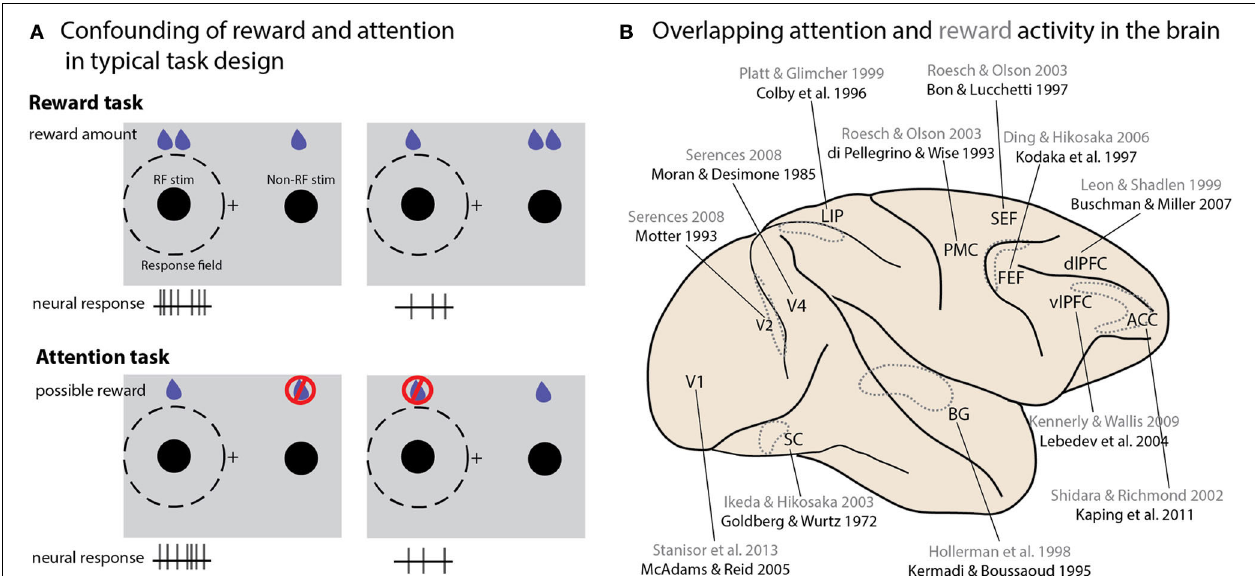
FIGURE 2 | Interactions between attention and reward. (A) A schematic illustration of typical tasks used to study reward and attention, and how the differences in potential reward and neural activity are similar between the two paradigms. Consider two studies conducted in V1 (Stˇani¸sor et al., 2013 and McAdams and Reid, 2005). To study the effect of reward size in the Stˇani¸sor task (schematically illustrated in the top panel), two potential targets appear, with colors indicating different reward values. Neural activity recorded at this point in the task reflects the relative value of the target in the RF (higher activity when the RF target offered a greater reward than the non-RF target); a subsequent cue instructs the monkey which target to saccade to. In the McAdams and Reid attentional paradigm (bottom panel), a cue indicates which of two stimuli should be monitored for a change, which instructs an eye